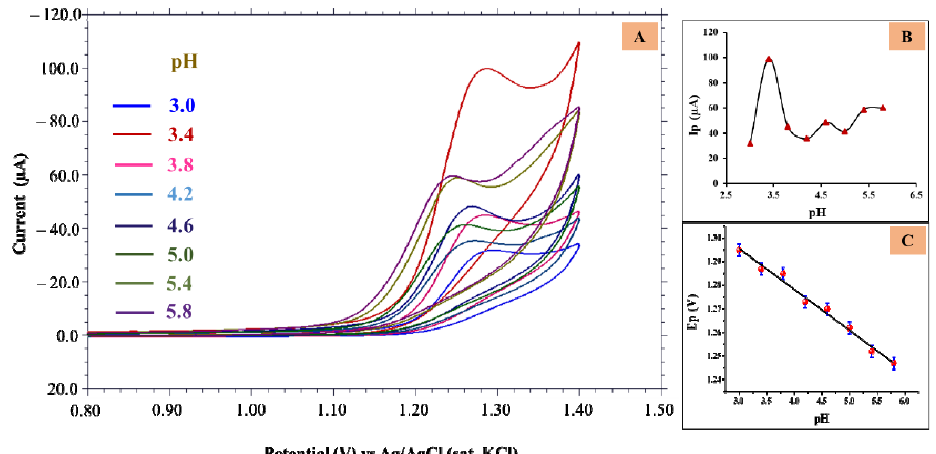
Figure 3. ( A ) Cyclic voltammograms obtained for 0.5 mM TMP at different pH; ( B ) Plot of Ip vs. pH; ( C ) Plot of Ep vs. pH.